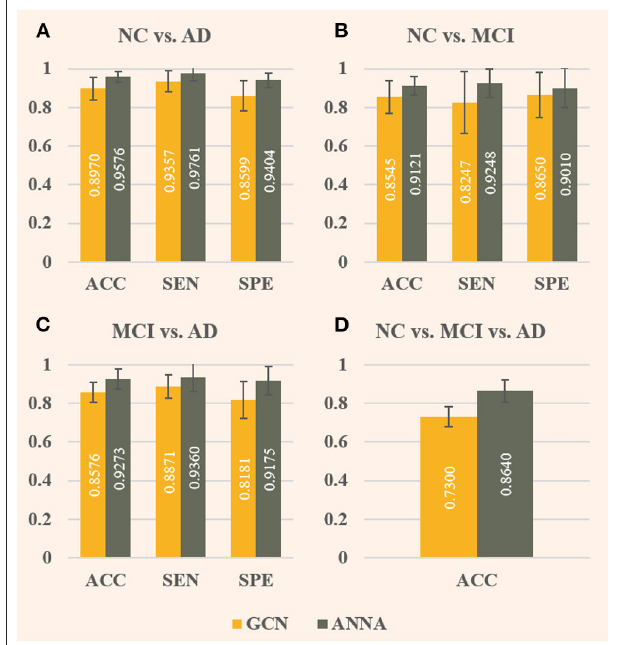
FIGURE 4 | Evaluation of baseline GCN and the improved GCN with ANNA unit for AD stages classification. The baseline GCN is denoted by GCN and plotted in yellow; the GCN with ANNA unit is denoted by ANNA and plotted in green. The specific index for each column is displayed in white in the middle. The error bars depict the standard deviation of the three evaluation indicators across the 10 different folds, respectively. The panels (A–D) , respectively, display the results of the four groups of classification